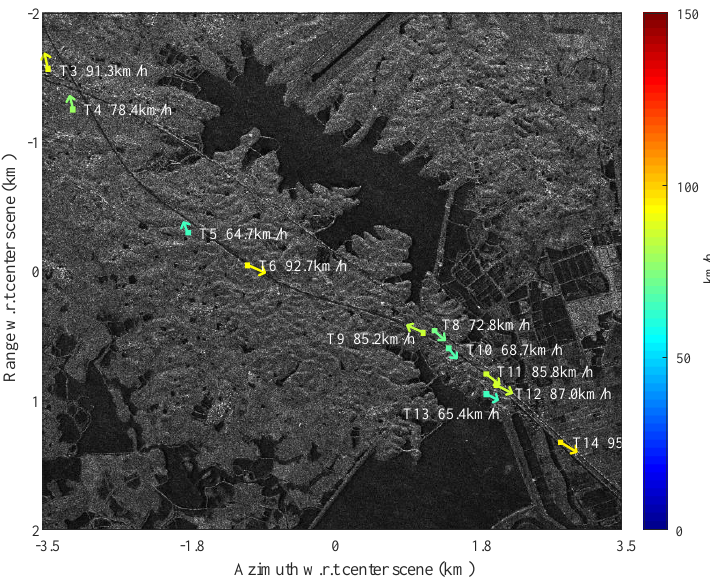
Figure 14. Vector velocity map of the moving targets (colors code the modulus ground velocity of the moving targets in km/h).